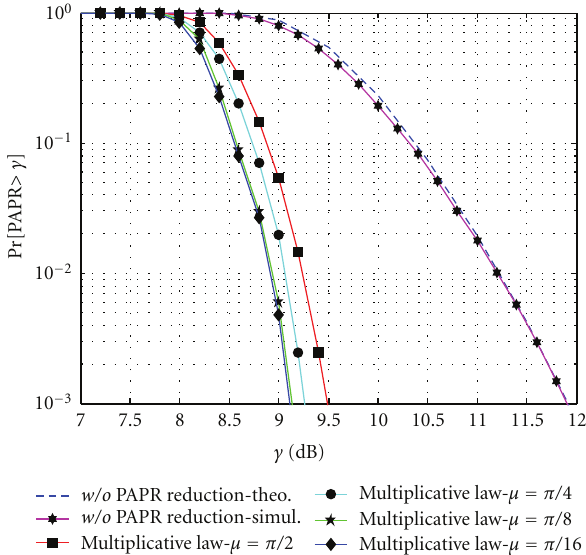
Figure 8: CCDF performance of multiplicative law using SOCP solution, continuous λ , 16-QAM, and 2k